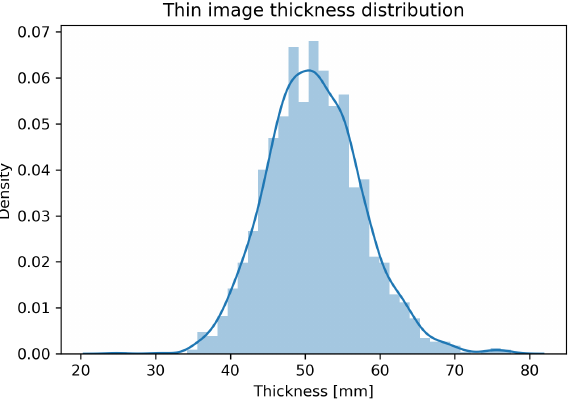
Figure 3. Thickness distribution of the training input